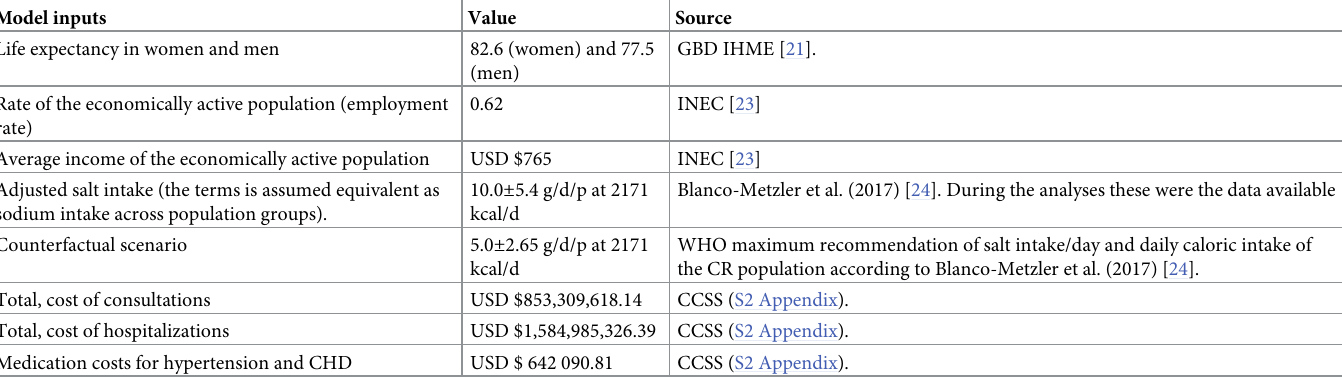
Table 1. Summary of the key model inputs and